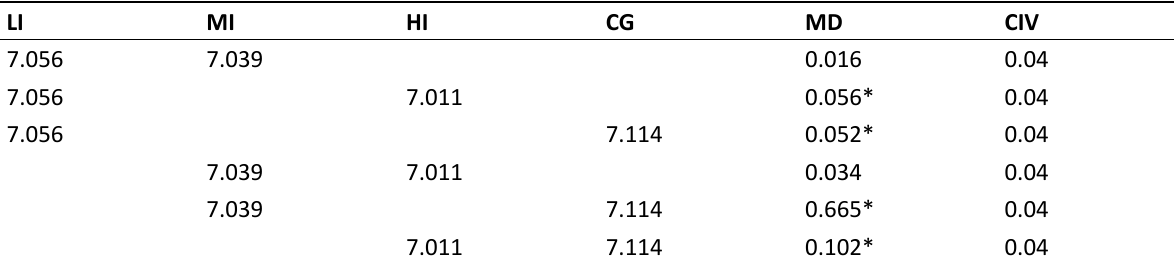
Table 3. Cheffe’s Test showing the differences between paired means of different groups on speed